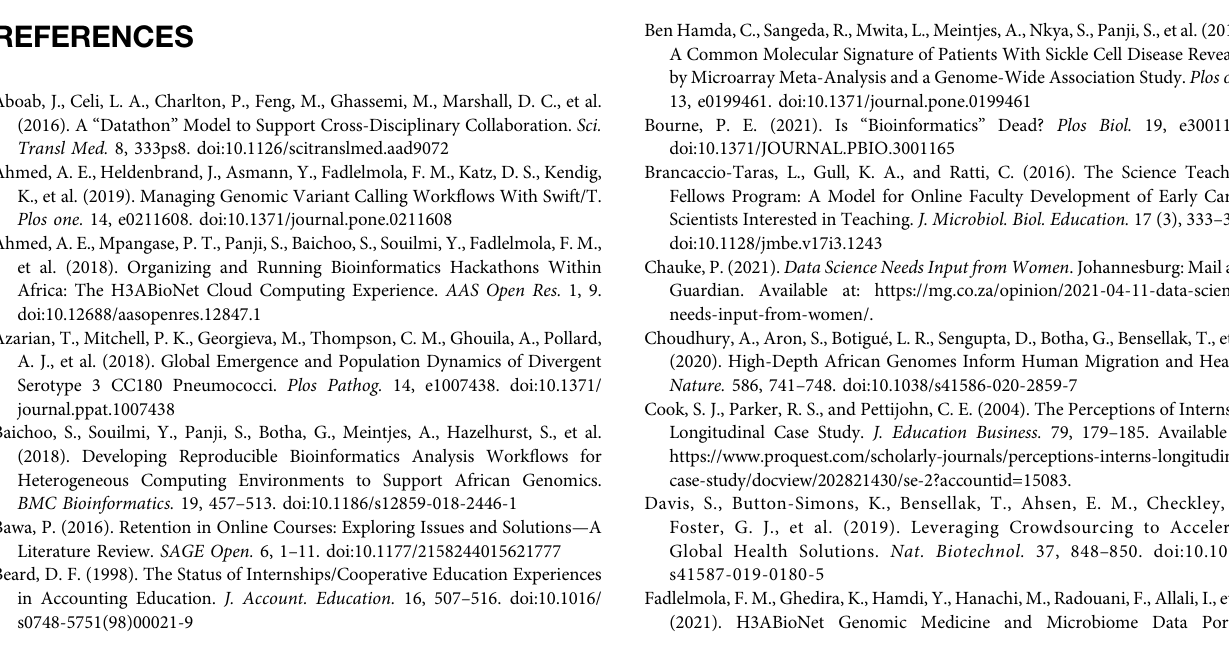
Supplementary Table S1 | | List of H3ABioNet training events by topic and